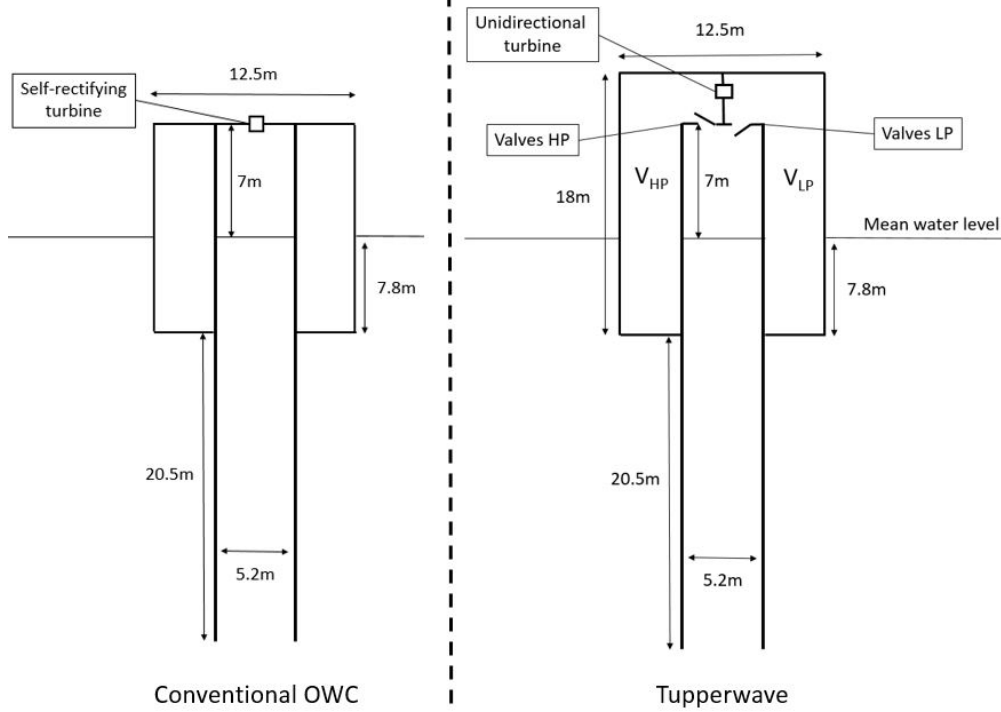
Figure 2. 2D schematic of the full-scale conventional OWC and Tupperwave devices. HP, High-Pressure; LP,